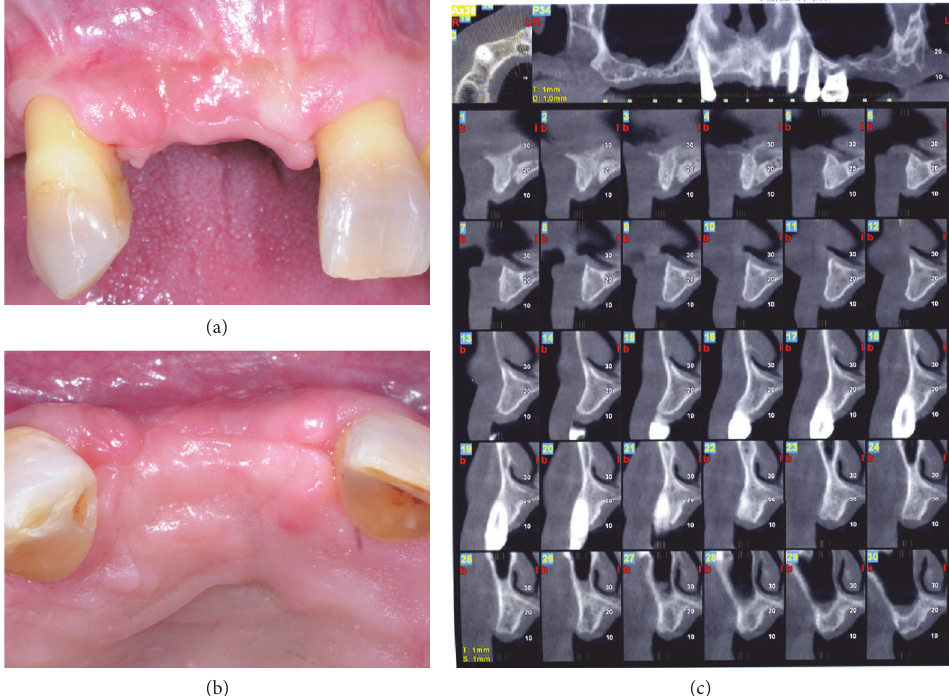
Figure 3: One year after the ridge reconstruction procedure ridge regeneration was achieved. Buccal view (a); occlusal view (b); cone-beam computed tomographic scan (c).